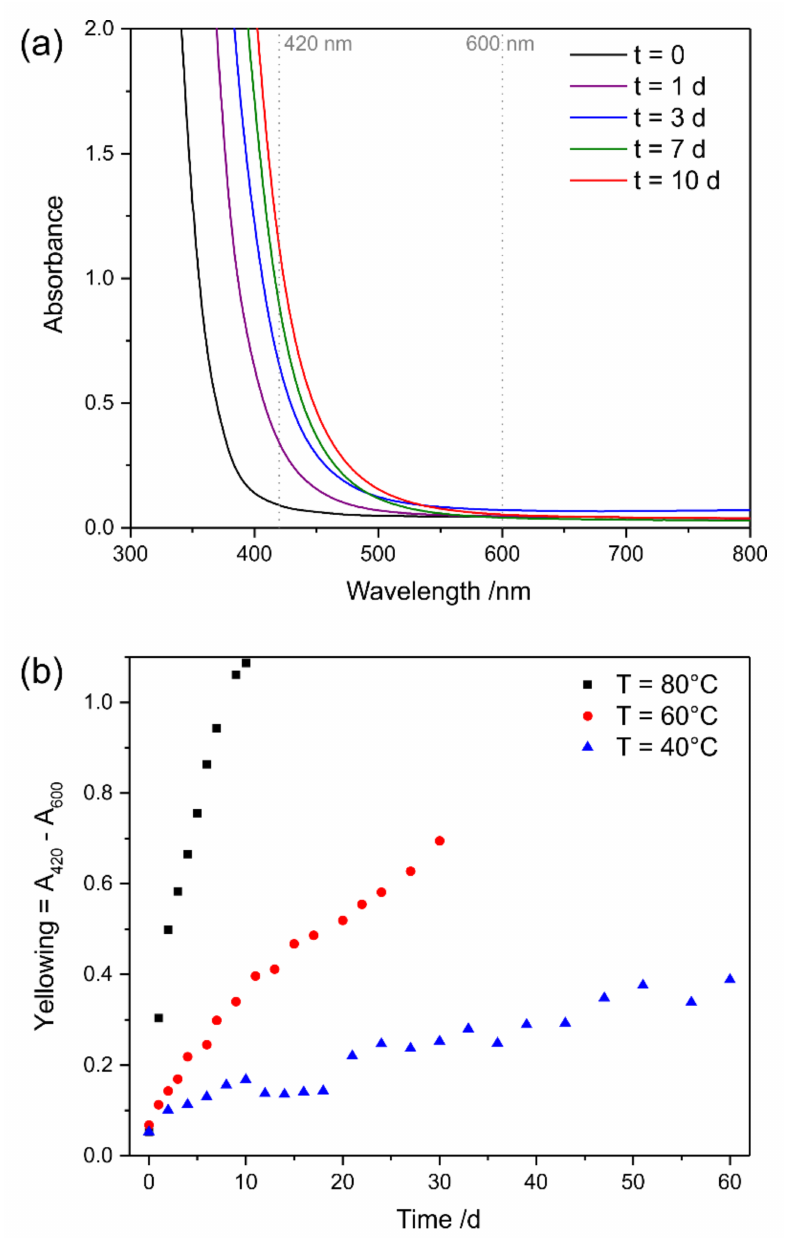
Figure 11. ( a ) UV–Vis spectra of Canada balsam after exposure to 80 ◦ C for different numbers of days, and ( b ) development of the yellowing factors over time during exposure of Canada balsam to different